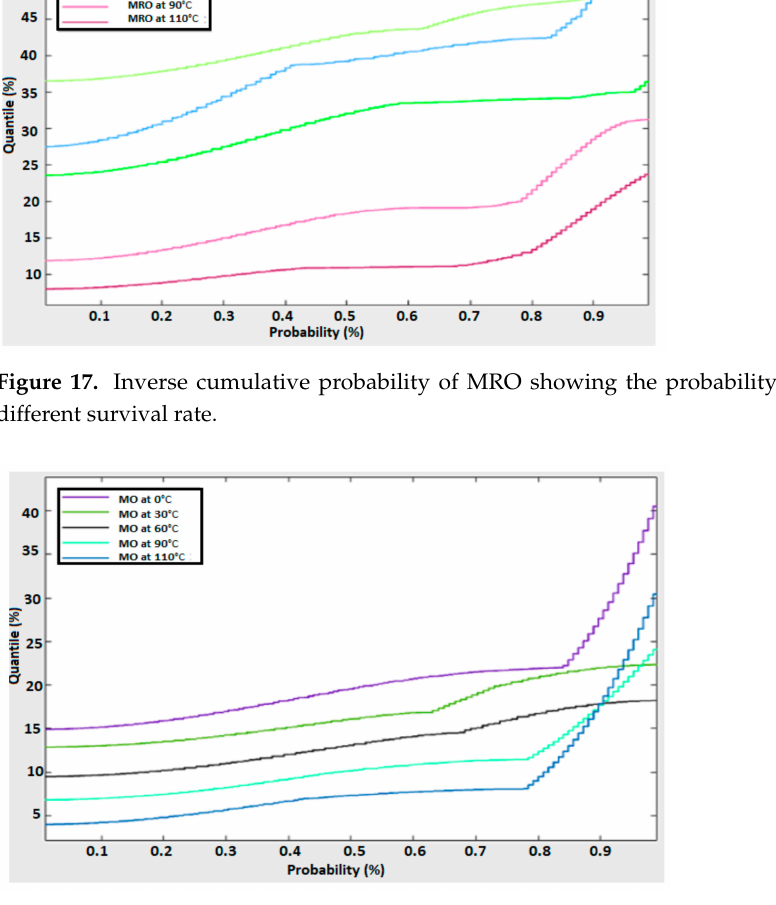
Figure 18. Inverse cumulative probability of MO showing the probability of data items with different survival rate.